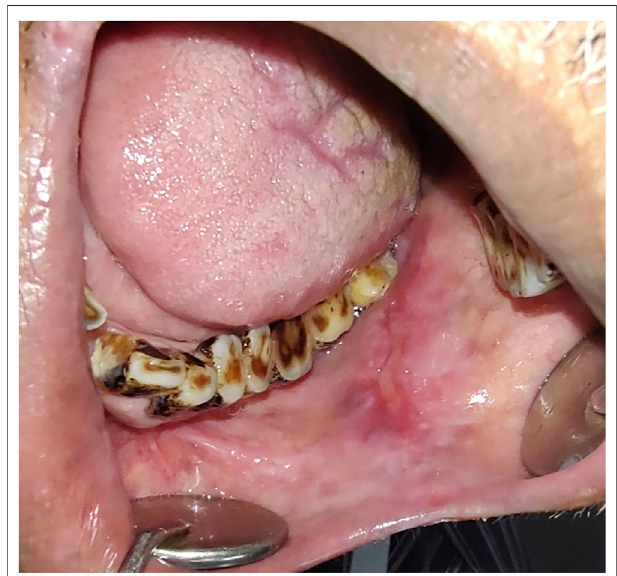
FIGURE 9 | Erythroplakia